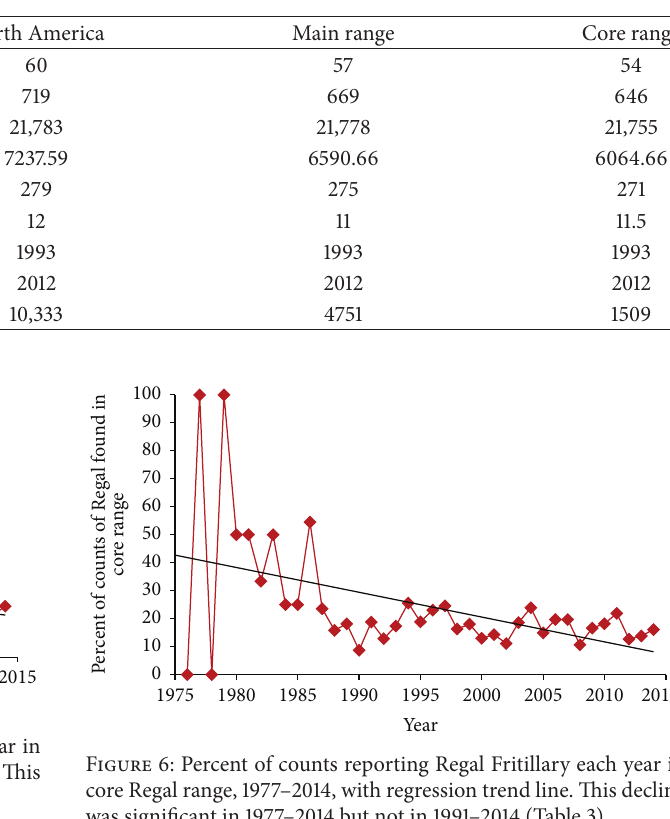
Table 2: Summary statistics on 4JC circles ever reporting a Regal Fritillary and all counts reported from those circles, by geographic scope.